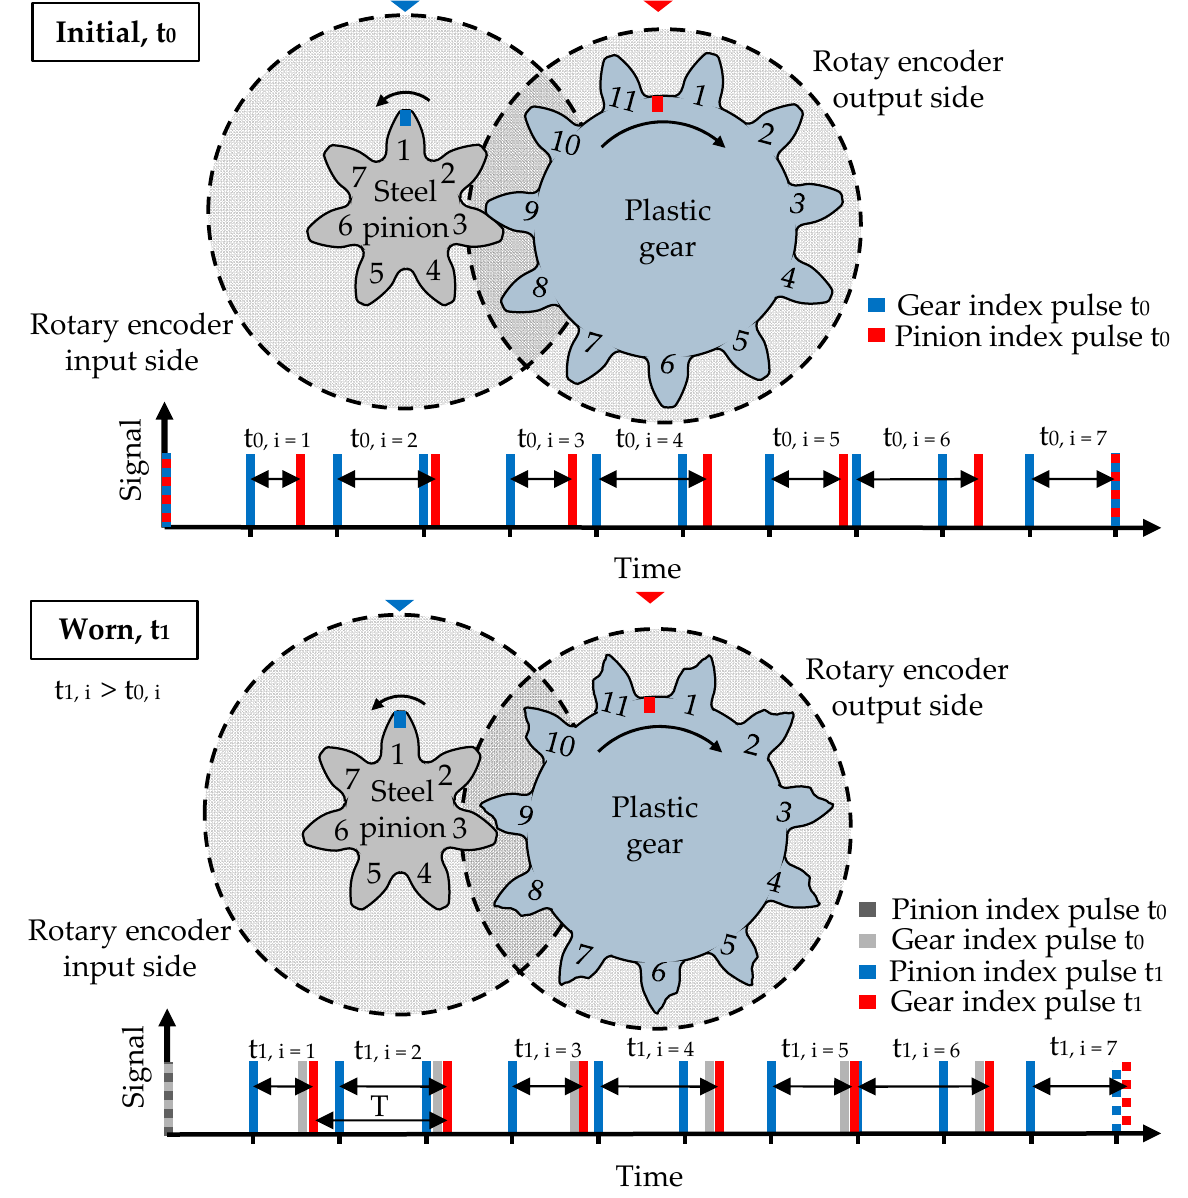
Figure 2. Tooth wear induced change of the timing di ff erence between input and output index pulses, reprinted from Ref. [22].